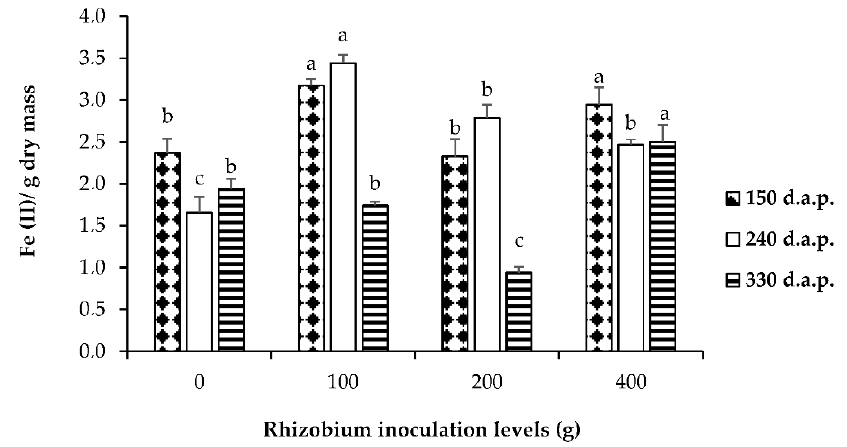
Figure 1. Ferric reduces antioxidant power assay (FRAP) of L. frutescens extracts in response to four rhizobium inoculation levels and different harvesting periods. Bars followed by different letters are significantly different at p ≤ 0.05.